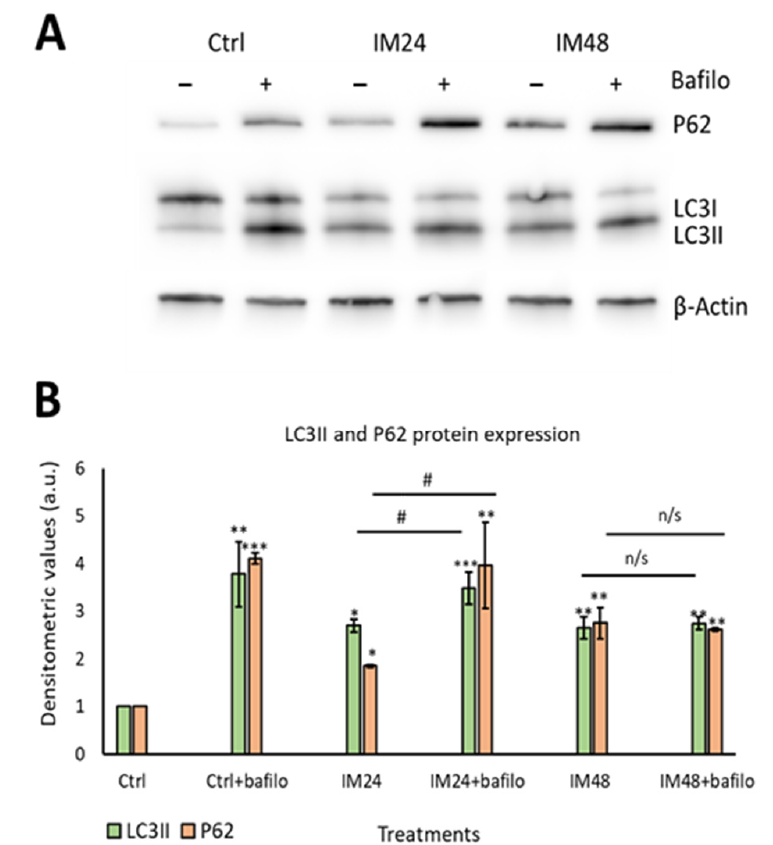
the lipidation of the autophagosome marker LC3I to LC3II and the removal of the P62 protein. A lysosomal inhibitor known as bafilomycin A1 (bafilomycin) was used to prevent protein degradation; therefore, if the cell had a functional autophagic flux, there would be an increase in protein levels after bafilomycin inhibition. Western blot analysis of 10 µ M IM treatment for 24 h caused 2.7 ± 1.3- and 1.9 ± 0.0-fold increases in LCII and P62, respectively ( p < 0.05), which further increased with bafilomycin to 3.5 ± 0.3- and 3.9 ± 0.9-fold increases ( p < 0.05). However, 10 µ M IM treatment for 48 h caused 2.6 ± 0.2- and 2.8 ± 0.3-fold changes of LC3II and P62, respectively, with no significant increases following bafilomycin co-treatment: 2.7 ± 0.1 and 2.6 ± 0.0 relative to the untreated control cells (1.0 ± 0.0) (Figure 4A,B).